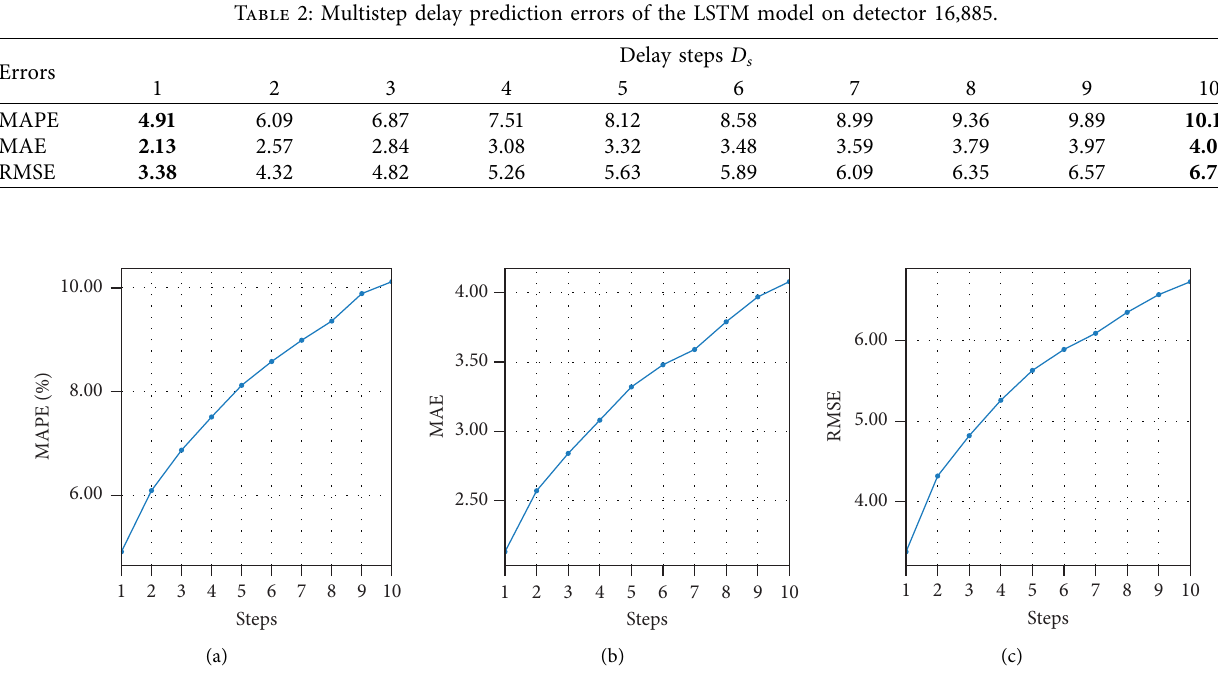
Figure 7: Multistep prediction errors of LSTM model on detector 16,885 with 5-minute interval. (a) MAPE. (b) MAE. (c) RMSE.